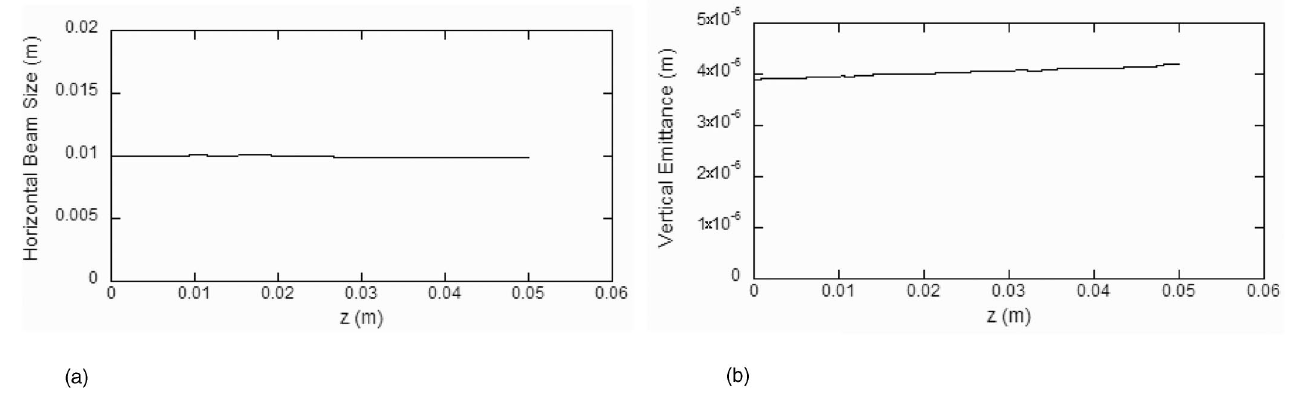
FIG. 13. (a) Horizontal beam size and (b) vertical emittance for a 14 mm